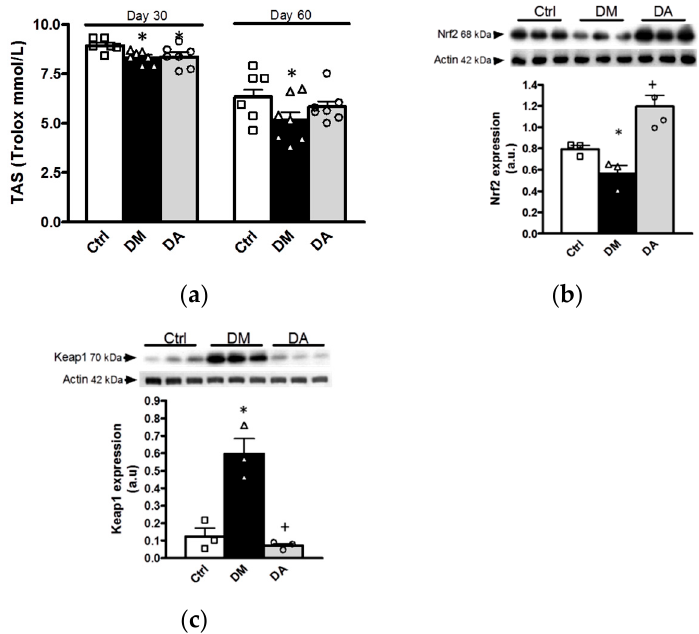
Figure 7. Evaluation of oxidative stress. ( a ) Total antioxidant status in plasma, ( b ) nuclear factor erythroid 2-related factor 2 (Nrf2) expression in kidney cortex, and ( c ) kelch-like ECH associated-protein 1 (Keap1) expression in kidney cortex. Ctrl: control; DM: diabetes; DA: diabetes treated with allicin; a.u: arbitrary units. For representative Western blotting, 3 randomly selected samples per group were analyzed. Results are presented as mean ± SEM and analyzed by one-way ANOVA. Statistical significance was established as * p < 0.05 vs. Ctrl, + p < 0.05 vs. DM.